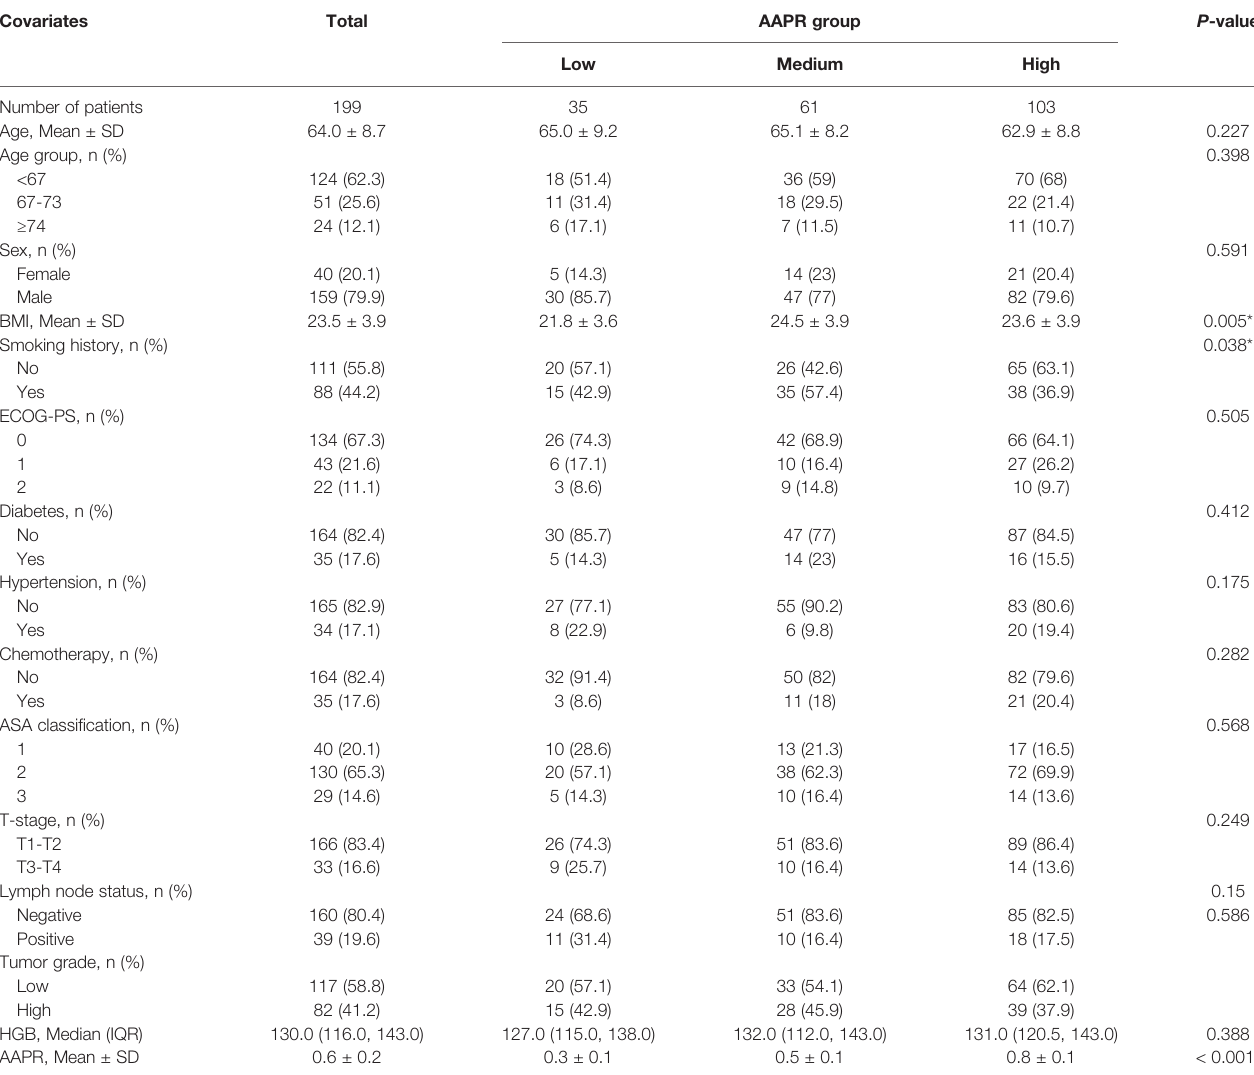
TABLE 1 | The relationship between AAPR groups and clinicopathological parameters in the present BC cohort (n = 199). Covariates Total